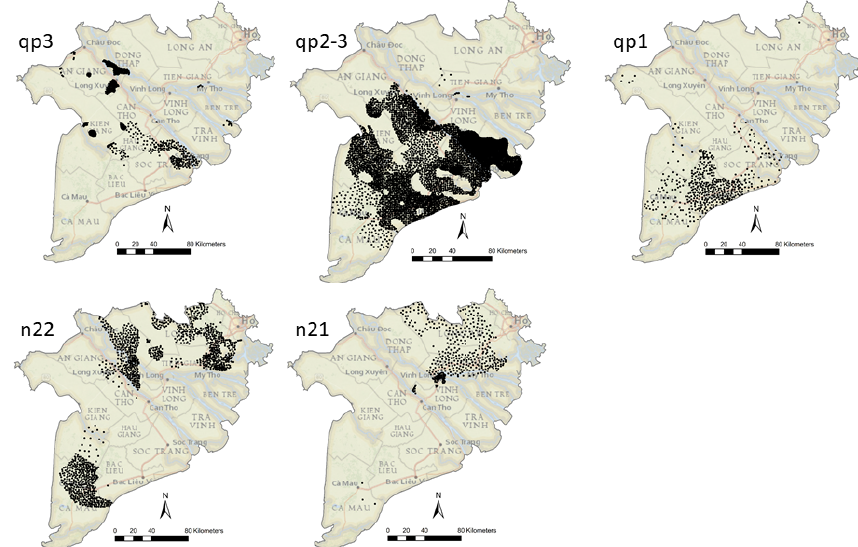
Figure 7. Spatial distribution of domestic extraction wells in the MKD, with known location and aquifer from which the groundwater is extracted. No data for the Holocene aquifer, qh, are available because of its predominant brackish/saline nature. Map copyright: © National Geographic, Esri, Garmin, HERE, UNEP-WCMC, USGS, NASA, ESA, METI, NCRAN, GEBCO, NOAA, increment P Corp.